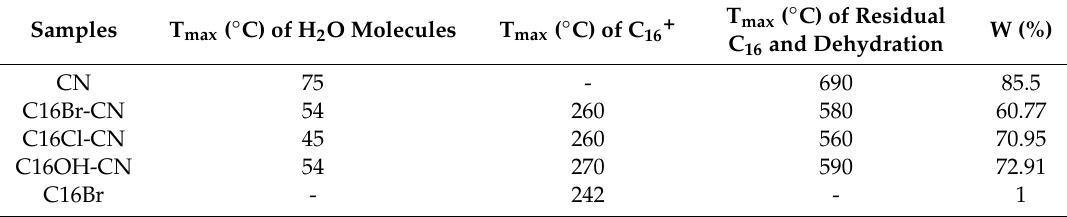
Table 4. Thermal properties of cloisite and derived